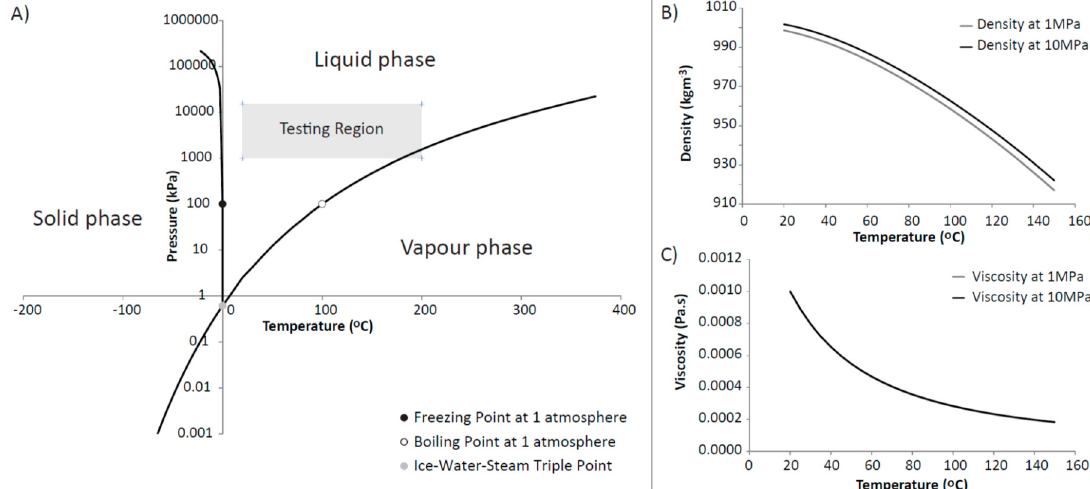
Figure 3. ( A ) Phase diagram of water (created using data from [36–39]); ( B ) Density of water at 1 and 10 MPa versus temperature; ( C ) Viscosity of water versus temperature for 1 and 10 MPa pressure. The